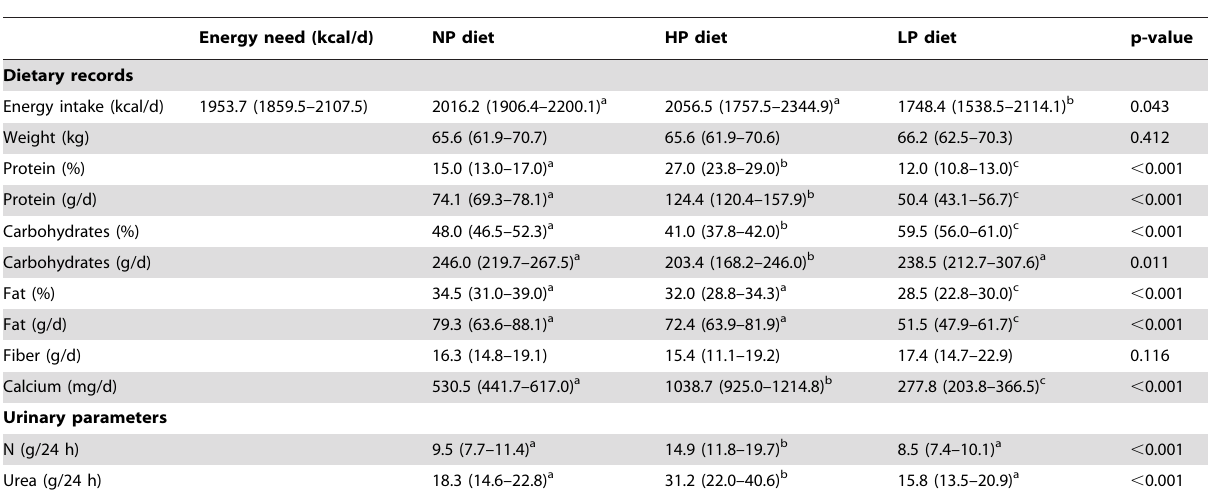
Table 1. Summary of dietary records and validating measures in